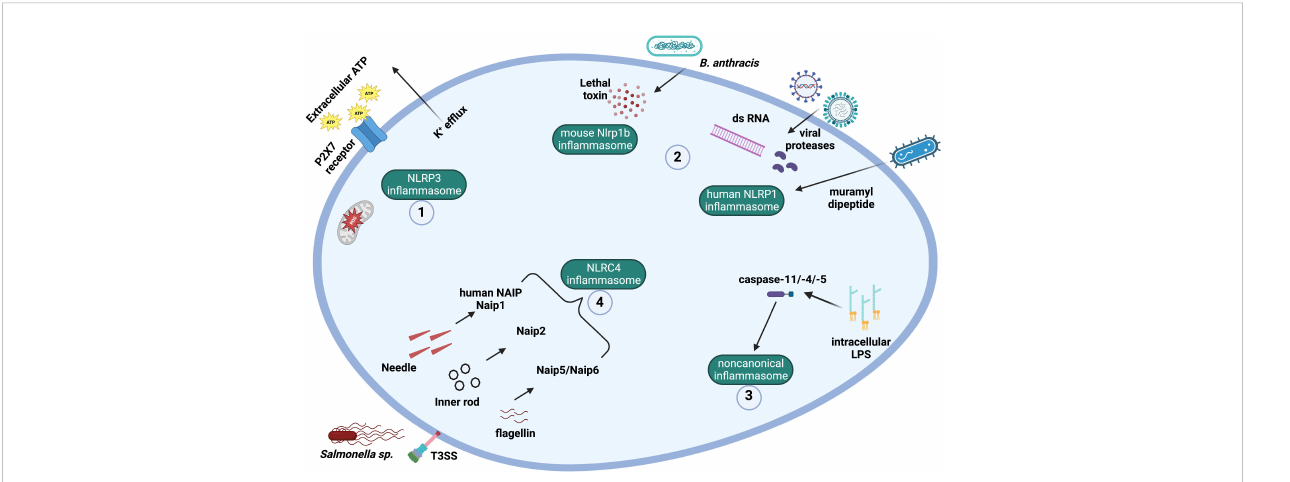
FIGURE 2 Mechanisms and ligands involved in canonical and noncanonical in fl ammasome activation. (1) The NLRP3 in fl ammasome can be activated by a plethora of signals, including potassium ef fl ux, mitochondrial ROS production, and extracellular ATP ligation to P2X7 receptor. (2) Muramyl dipeptide, SARS-CoV-2 infection, viral proteases and double-stranded viral RNA can lead to the activation of the human NLPR1 in fl ammasome. The lethal toxin produced by Bacillus anthracis activates murine Nlrp1b. (3) The noncanonical in fl ammasome is activated by intracellular LPS from Gram-negative bacteria. Intracellular LPS directly binds to caspase-11 (in mice) or caspase-4/-5 (in humans), which become activated. (4) The protein NAIP in humans can recognize T3SS (type III secretion system) needle protein, while the different rodent Naips can recognize different bacterial ligands, such as T3SS needle protein (Naip1), T3SS inner rod protein (Naip2), and fl agellin (Naip5 and Naip 6). Following PAMP ligation, NAIPs bind to and activate the NLRC4 in fl